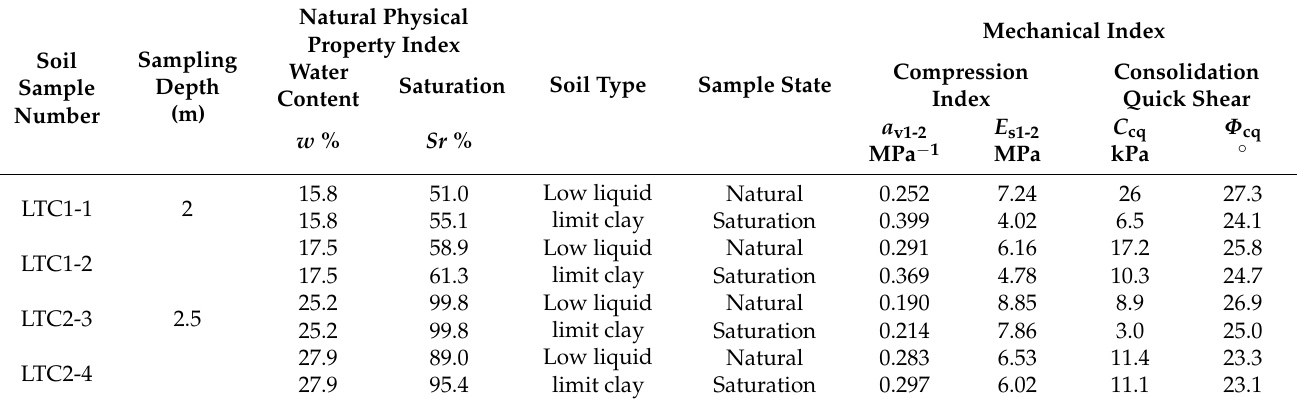
Table 2. Luohuang Town mechanical properties test